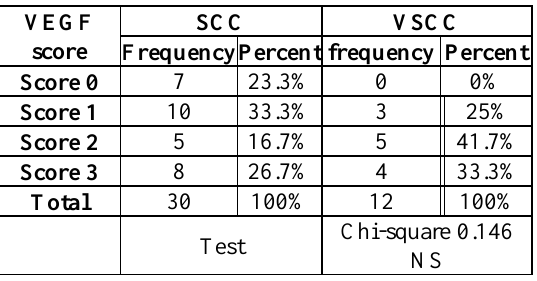
Table 2: VEGF score in OSCC and VSCC VEGF